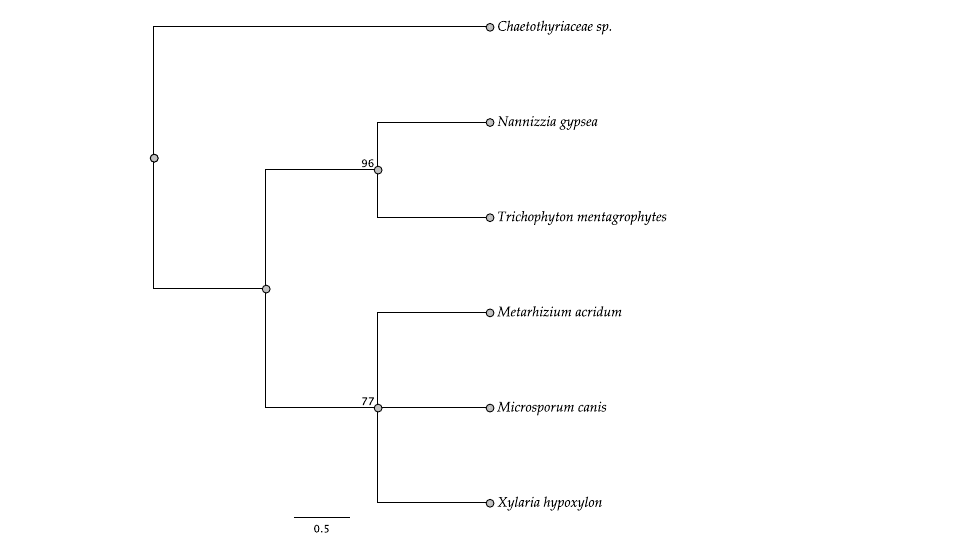
Figure 11. Maximum parsimony DNA tree resulting from the analysis of the swnH1 – swnT intergenic region sequence data. Bootstrap confidence values from 1000 bootstrap replicates are presented at each corresponding node. Fungal orders are indicated next to each organism/clade.